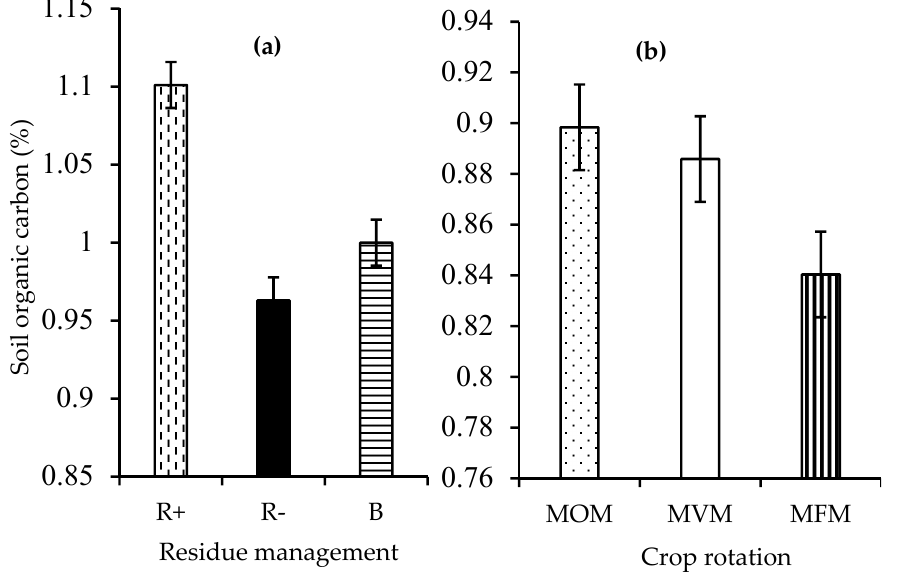
Figure 3. Effect of ( a ) crop residue management and crop rotation ( b ) on soil organic carbon at the 0–5 cm and 5–10 cm depths, respectively.